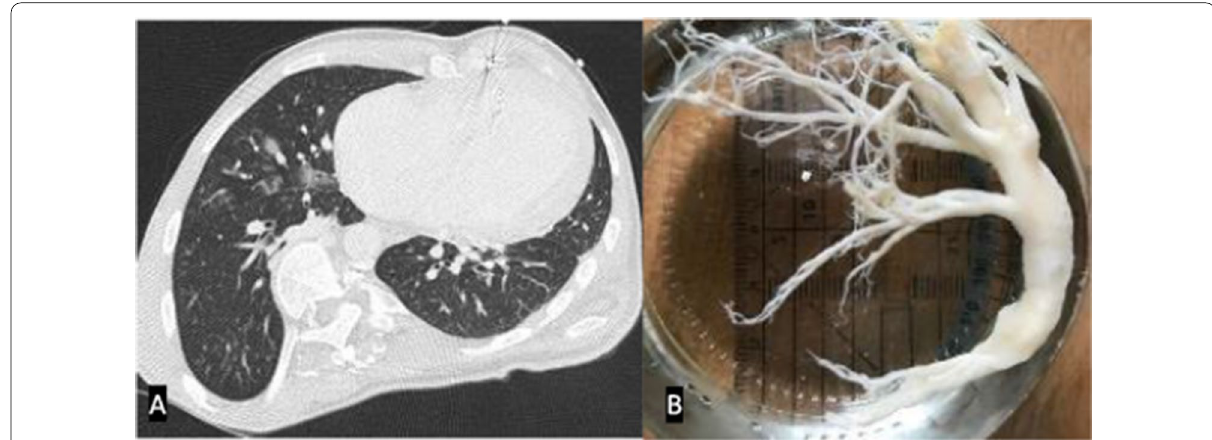
Fig. 16 A CT Axial image in the lung window in a patient with plastic bronchitis. Note the groundglass parenchymal lung changes in the right upper lobe. B A bronchial cast retrieved in a patient with plastic